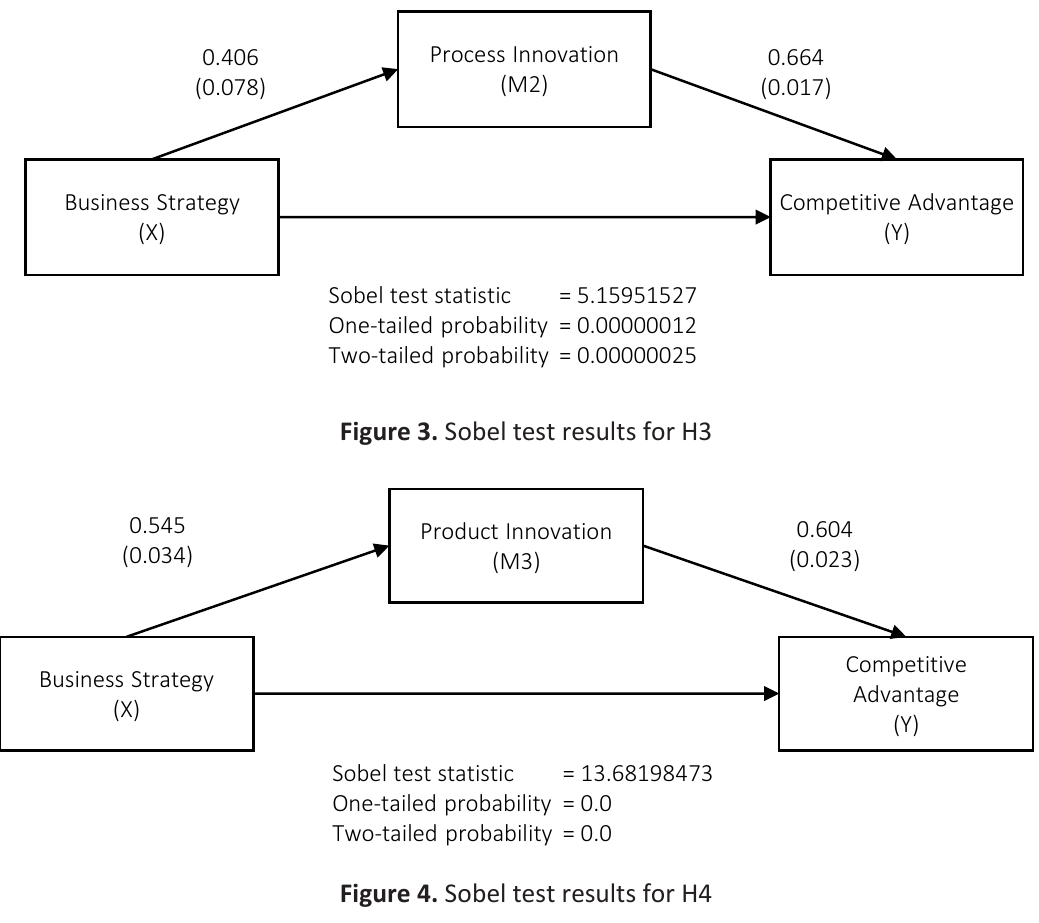
Figure 4. Sobel test results for